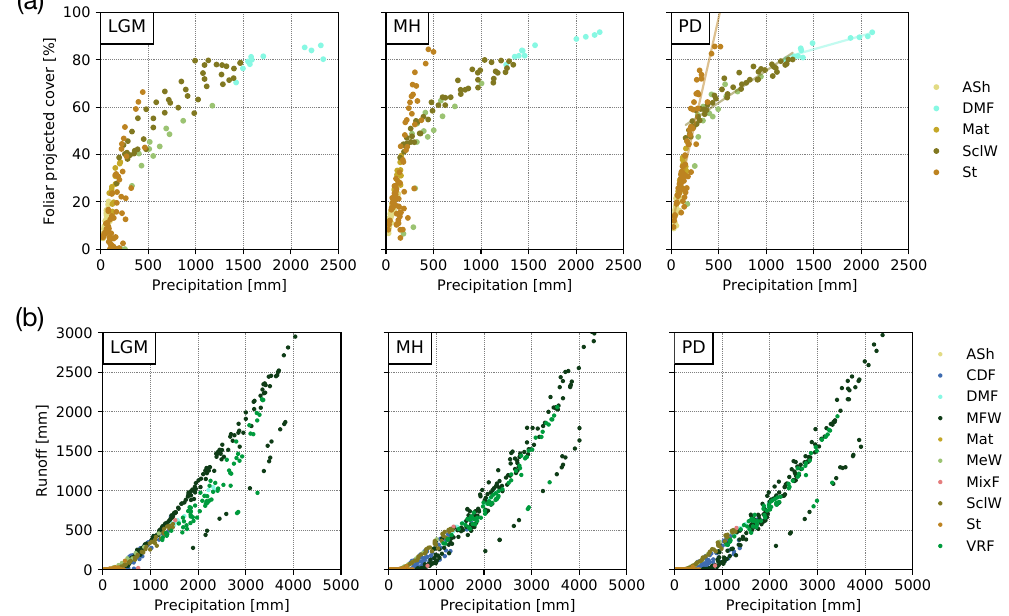
Figure 8. (a) Foliar projected cover (FPC) and (b) surface runoff as a function of annual average rainfall for the Last Glacial Maximum (LGM), the mid-Holocene (MH), and present day (PD) (“ASh” is arid shrubland, “CDF” is cold deciduous forest, “DMF” is deciduous “Maule” forest, “MFW” is Magellanic forest/woodland, “Mat” is matorral, “MeW” is mesic woodland, “MixF” is mixed forest, “SclW” is sclerophyllous woodland, “St” is steppe, “VRF” is Valdivian rainforest; temperate and boreal forest biomes (CDF, MixF, VRF, MFW) excluded from subplot (a) as they are also strongly dependent on